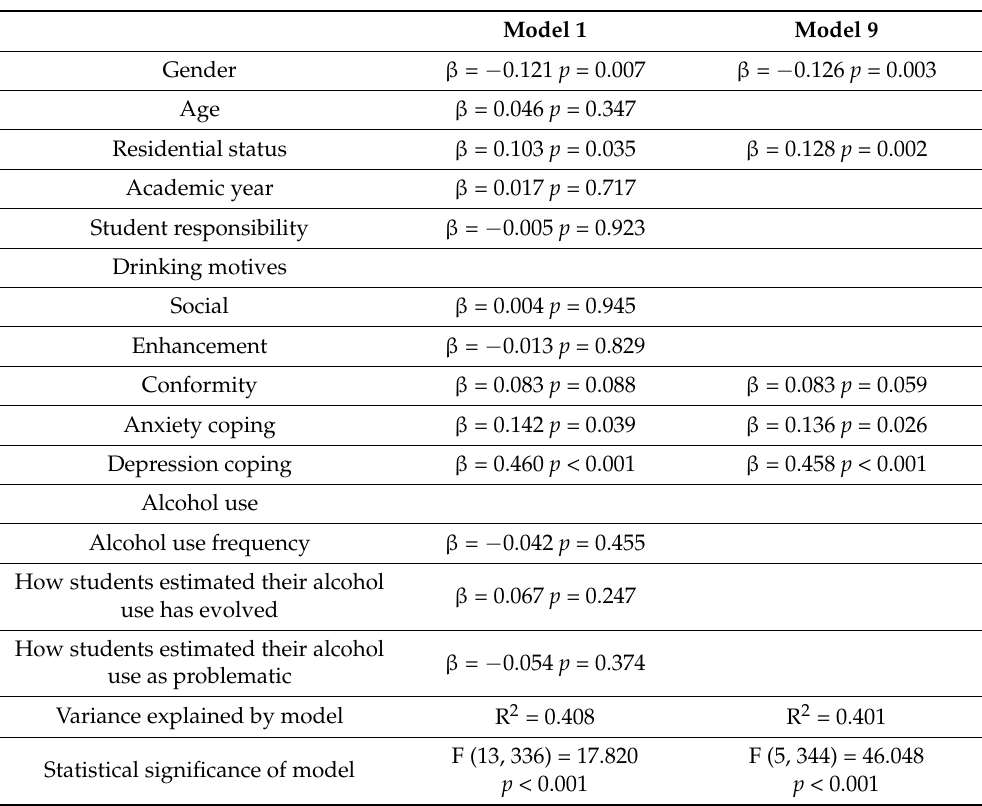
Table 6. Factor associated with level of psychological distress (multiple linear regressions, backward elimination technique) ( n =